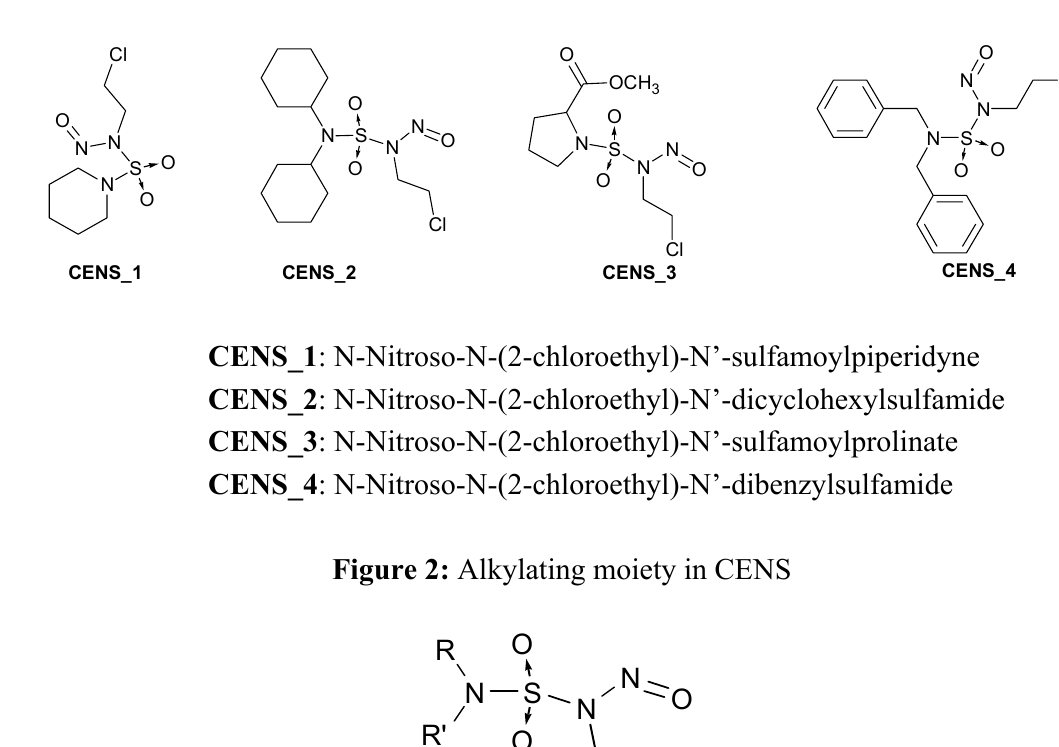
Figure 1. The structures of the four CENS.